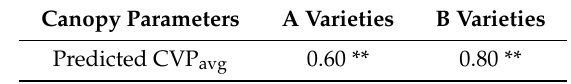
Figure 6. Random forest (RF) regression results for the predicted and measured rice canopy volume parameter (CVP) values (samples for validation): The circled parts in the figures indicate the parts where the CVP measured values become larger. Table 8. Correlations between the RF-predicted CVP avg and yield.